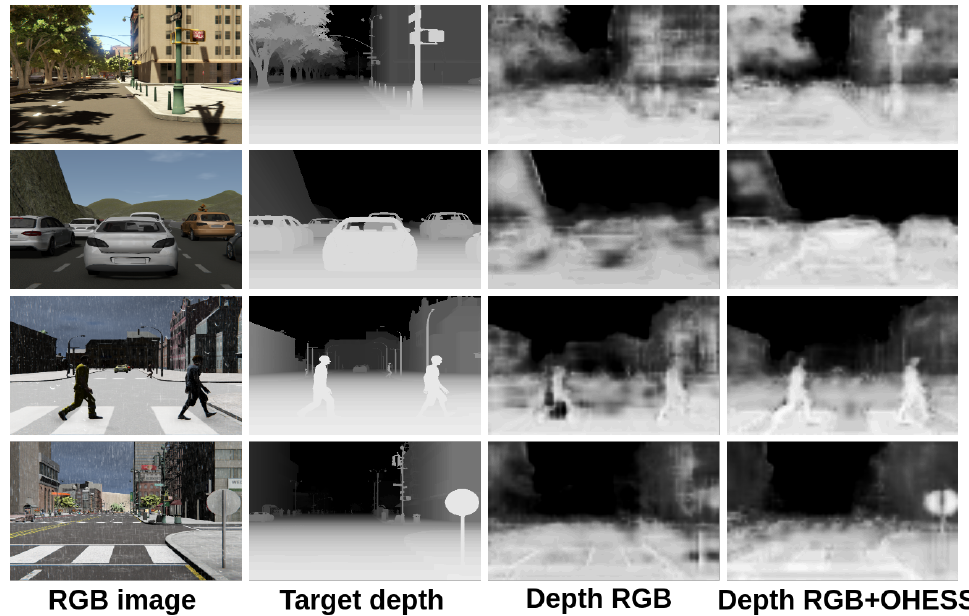
Figure 13. Results obtained with the SCRX CNN model (visually enhanced).